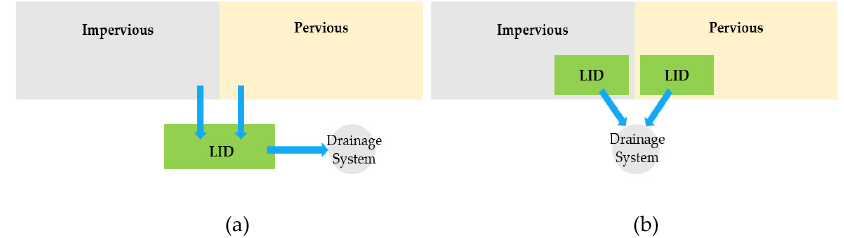
Figure 4. LID modeling method 1 schematic (a). LID modeling method 2 schematic (b) [23,24].